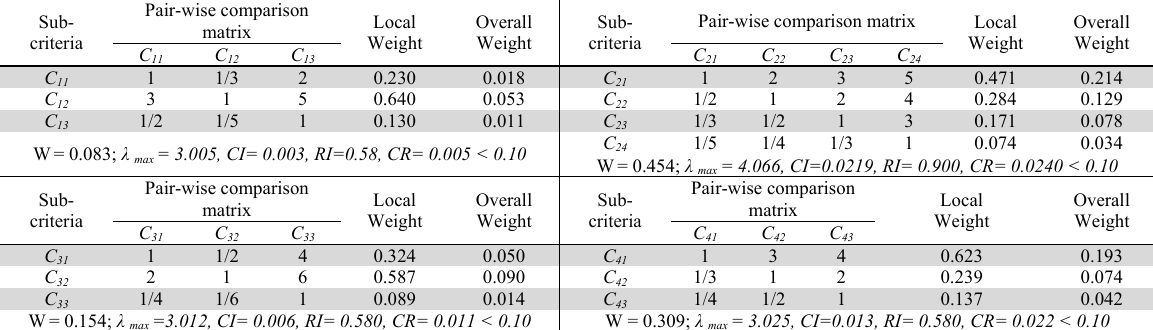
Local Overall Weight Weight